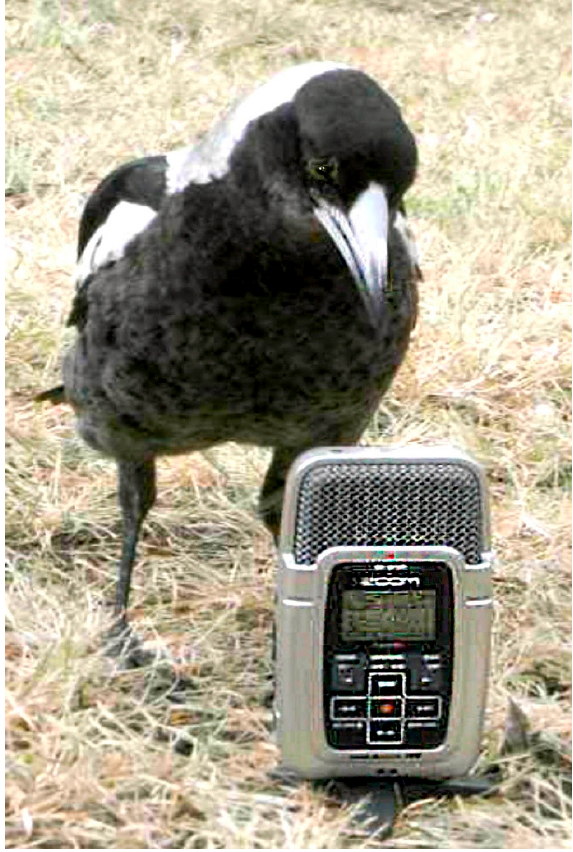
Figure 10. Juvenile magpie examining the small digital playback unit positioned on the ground [48]. Note that the speaker (top grid) is two-sided and works on either side of the unit. Here, the juvenile’s inspection occurs on the side from which the sound emanated.